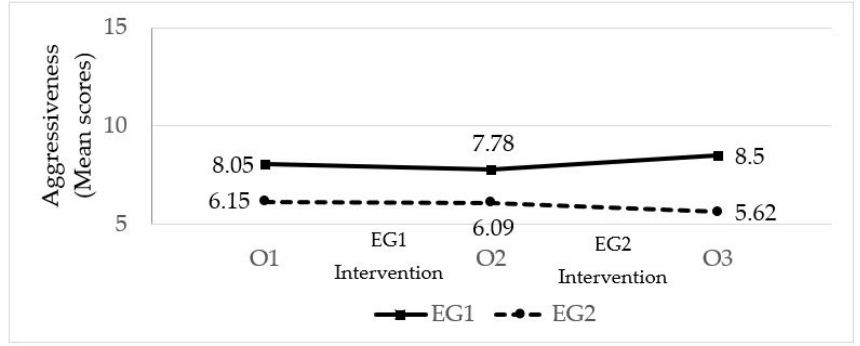
Figure 3. The e ff ect of the intervention on pupil aggressiveness (n GE1 = 40; n GE2 = 33; EG = Experimental Group; O =